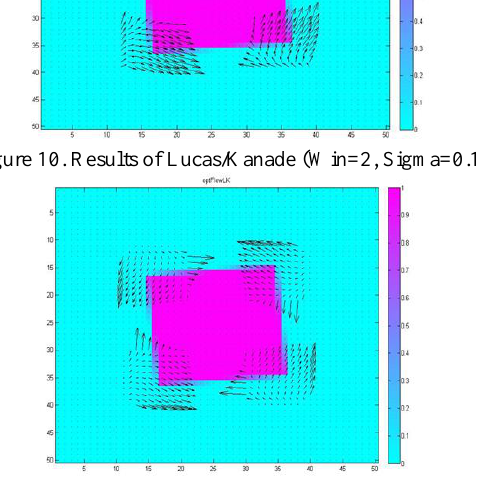
Figure 11. Results of Lucas/Kanade (Win=2, Sigma=0.5)